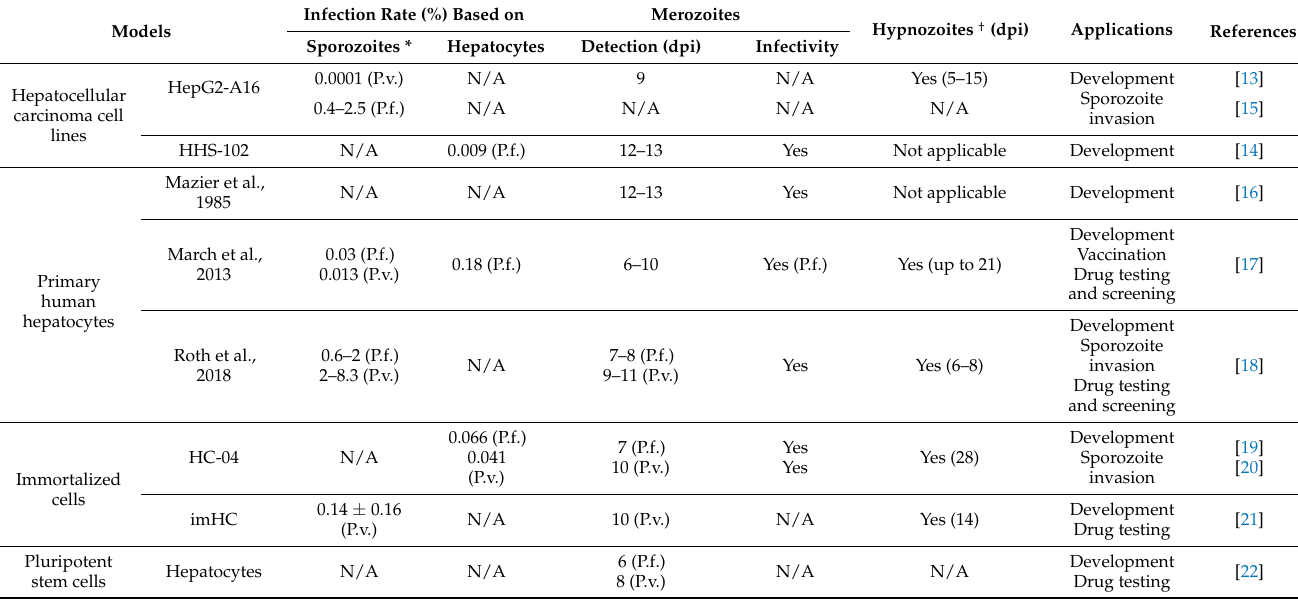
Table 1. Liver-like models applied in preclinical studies of human